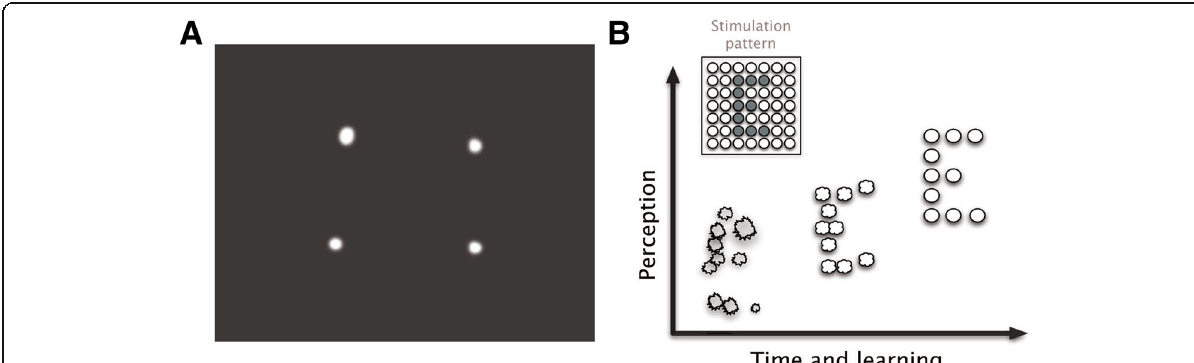
Fig. 1 Examples of patterned phosphenes. a : Possible perception generated by stimulating simultaneously 4 electrodes arranged as a square. b : The neural plasticity of the visual system can contribute to ever-improving correlation between the physical world and evoked phosphenes. Immediately after implantation the evoked phosphenes are likely to induce a poor perception of an object (the letter “ E ” in this example). However, appropriate learning and rehabilitation strategies will contribute to provide concordant